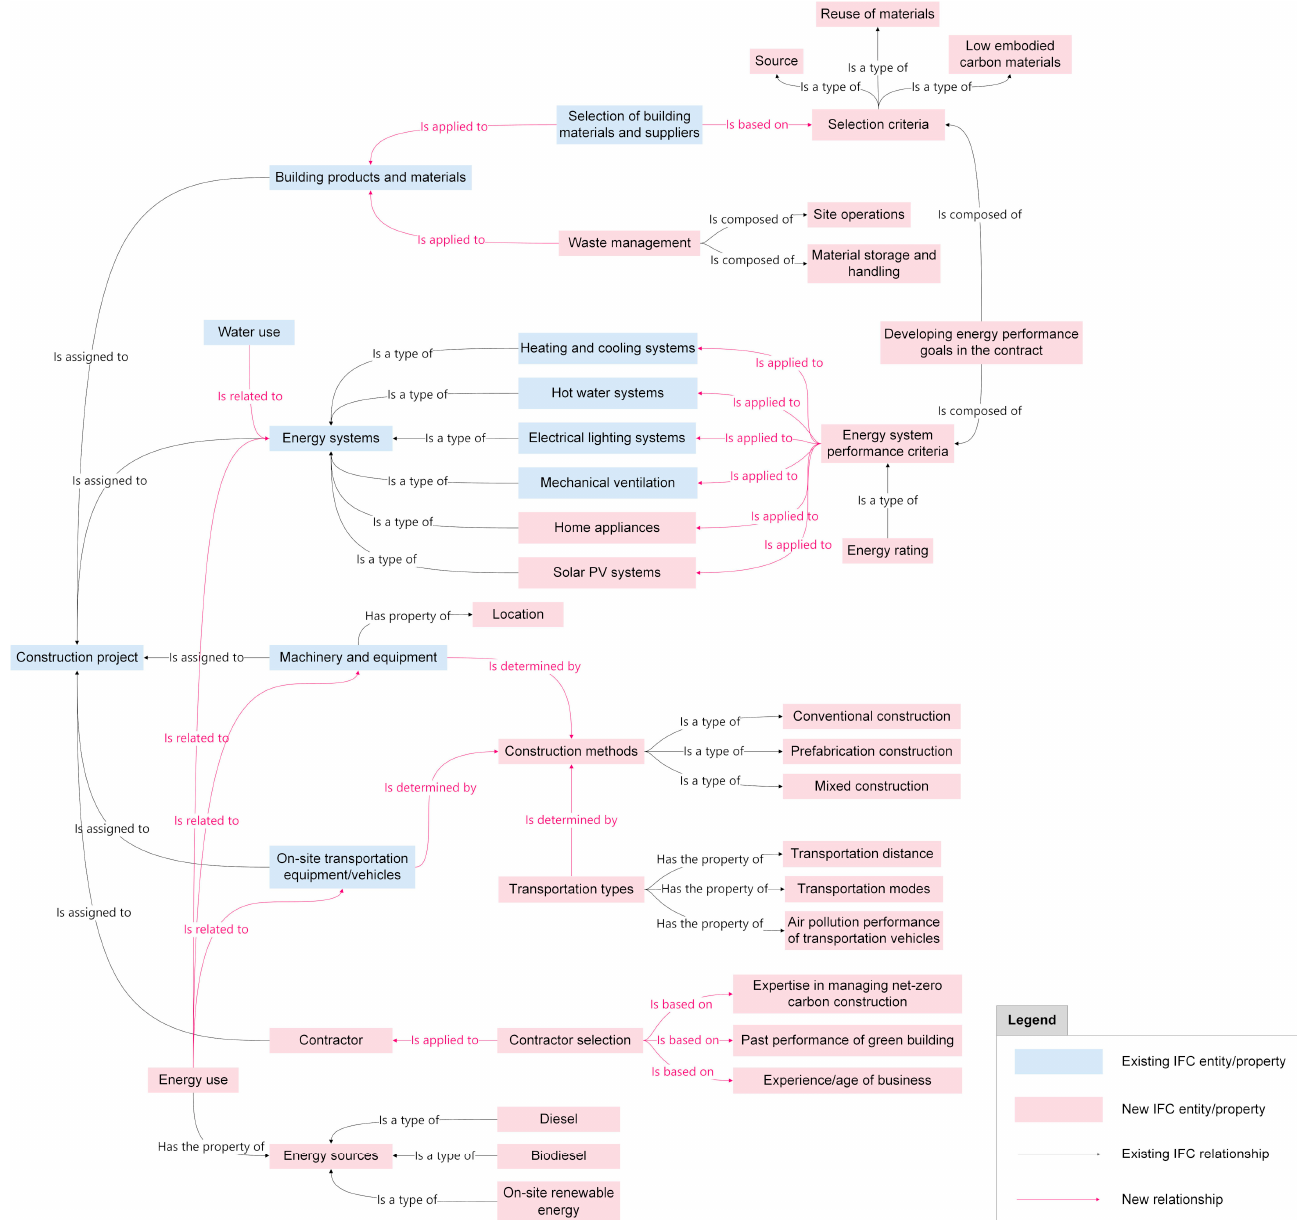
Figure 14. Illustration of an extension of additional entities, properties, and relationships to repre- sent key decision variables affecting net-zero-carbon building outcomes at construction stage, and the links to the existing IFC